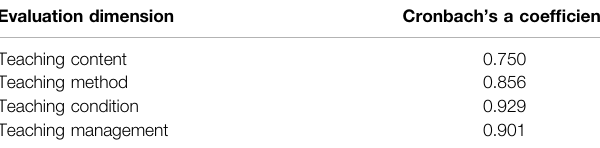
TABLE 2 | Survey sample background information.